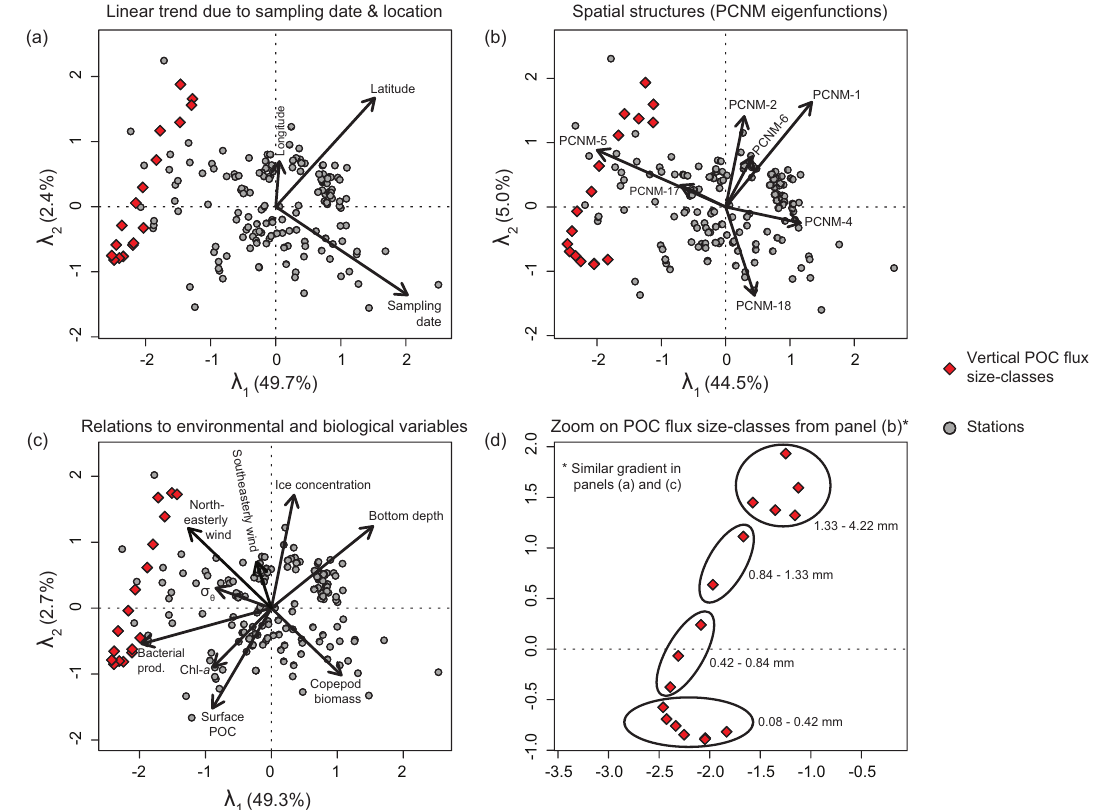
Fig. 14. Ordination plots of axes I and II from redundancy analyses (RDAs) conducted between the 17 vertical POC flux size classes (i.e., used as “species”), the 154 station locations, and the three reduced models obtained from the forward selection procedures: (a) linear trend due to sampling date and location, (b) variance from the PCNM sinusoidal-like waveform functions, and (c) trend induced by the set of significant environmental and biological variables. The list of all biophysical variables available for the present study is presented in Table 4. Panel (d) is a zoom on the ordination gradient of POC flux size classes (expressed in equivalent spherical diameter) as obtained from the PCNM RDA, but the gradient is similar in panels (a) and (c) . Details from the forward selection procedures are presented in Table 3. Spatial patterns corresponding to the PCNM functions and associated canonical axes are presented in Fig. 15. PCNM: principal coordinates of neighbor matrices (Borcard et al.,